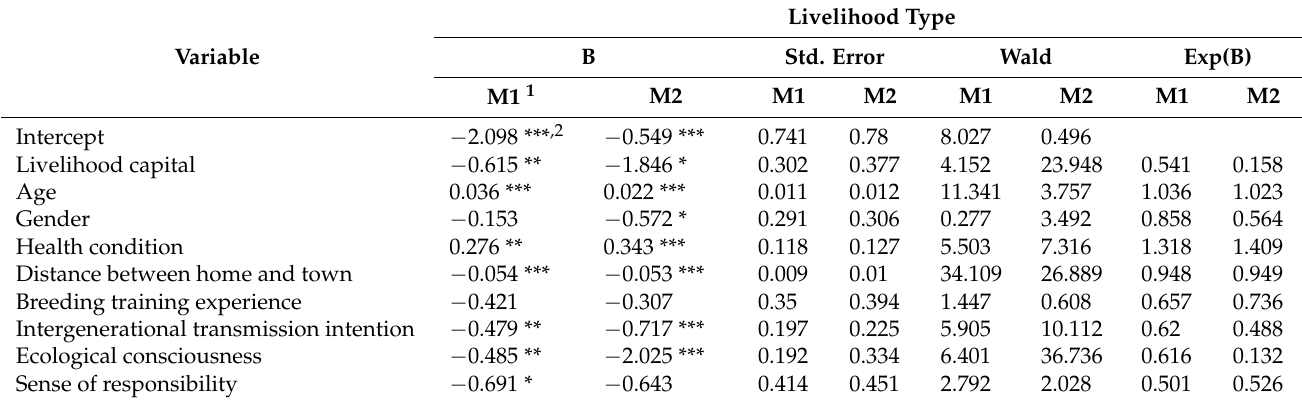
Table 4. Results of total moderating effect.